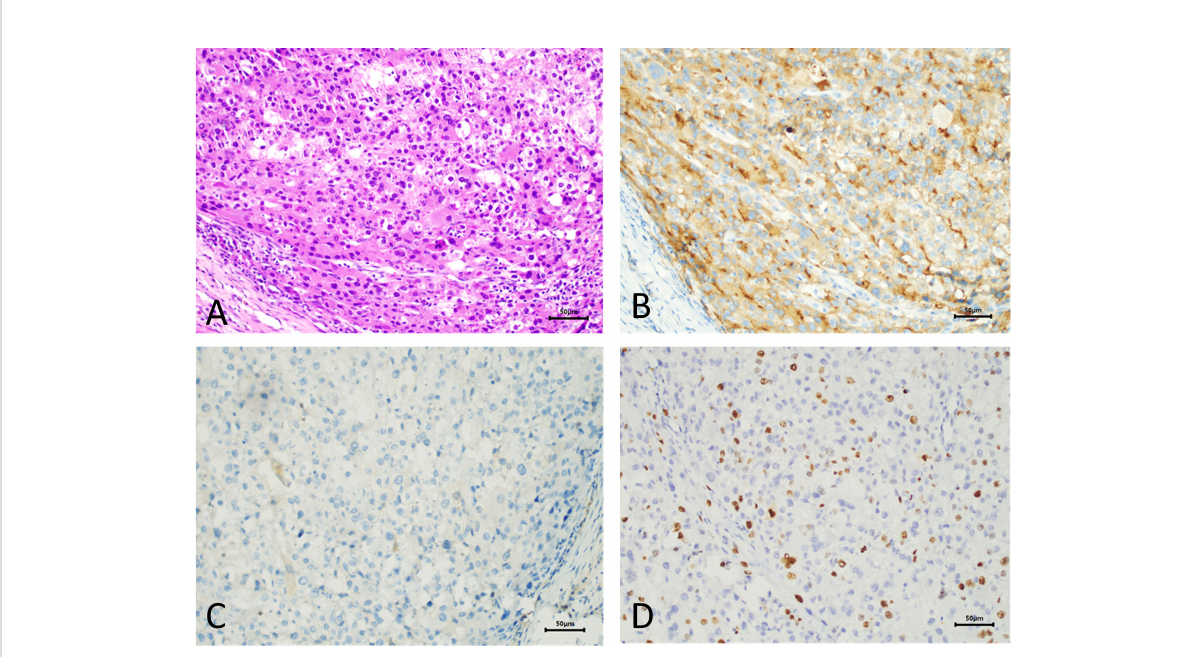
FIGURE 3 Pathological manifestations of hepatocellular metastasis. Hematoxylin – eosin staining (×200) (A) . Immunohistochemistry: GPC-3 (×200) (B) . Immunohistochemistry: hepatocyte (×200) (C) . Immunohistochemistry: Ki-67 (×200) (D)